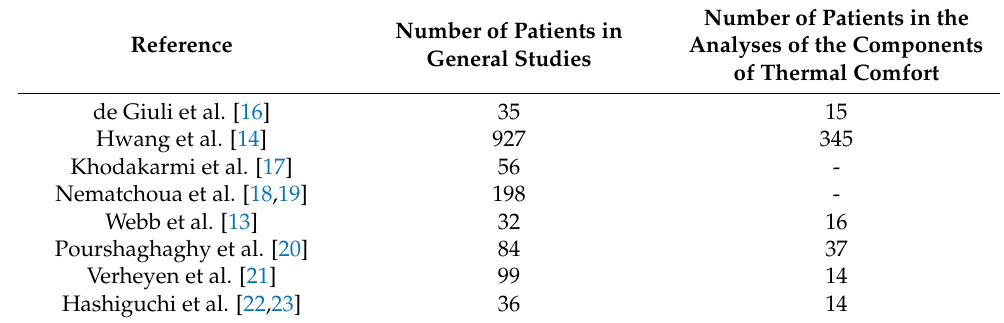
Table 1. Patients population in general research and detailed research